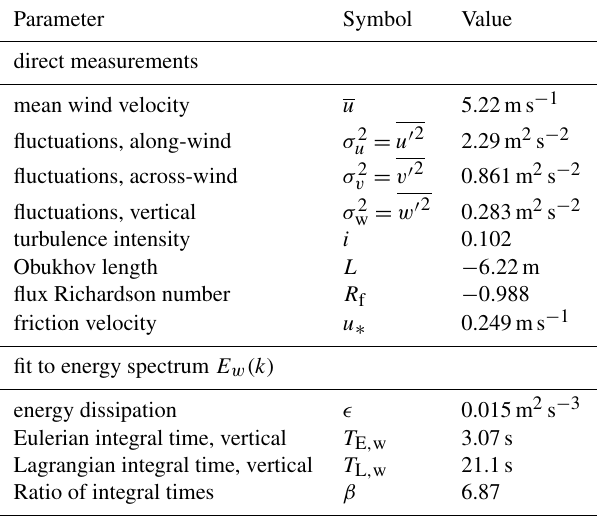
Table 2. Measured turbulence parameters from 10:27 to 10:32UTC. Parameter